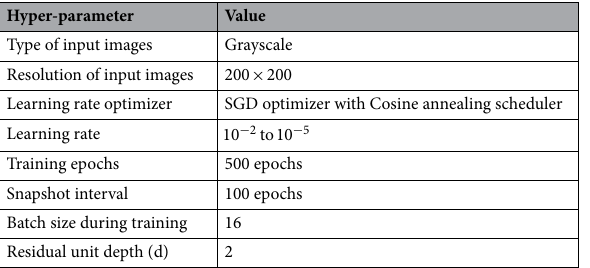
Table 2. Summary of hyperparameters and their values used during the training